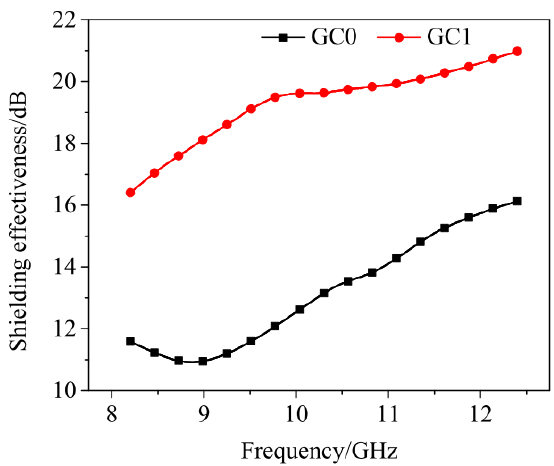
Figure 4. Comparison of shielding effectiveness of reinforced CCMs with and without rGO. Reprinted from Ref. [53].